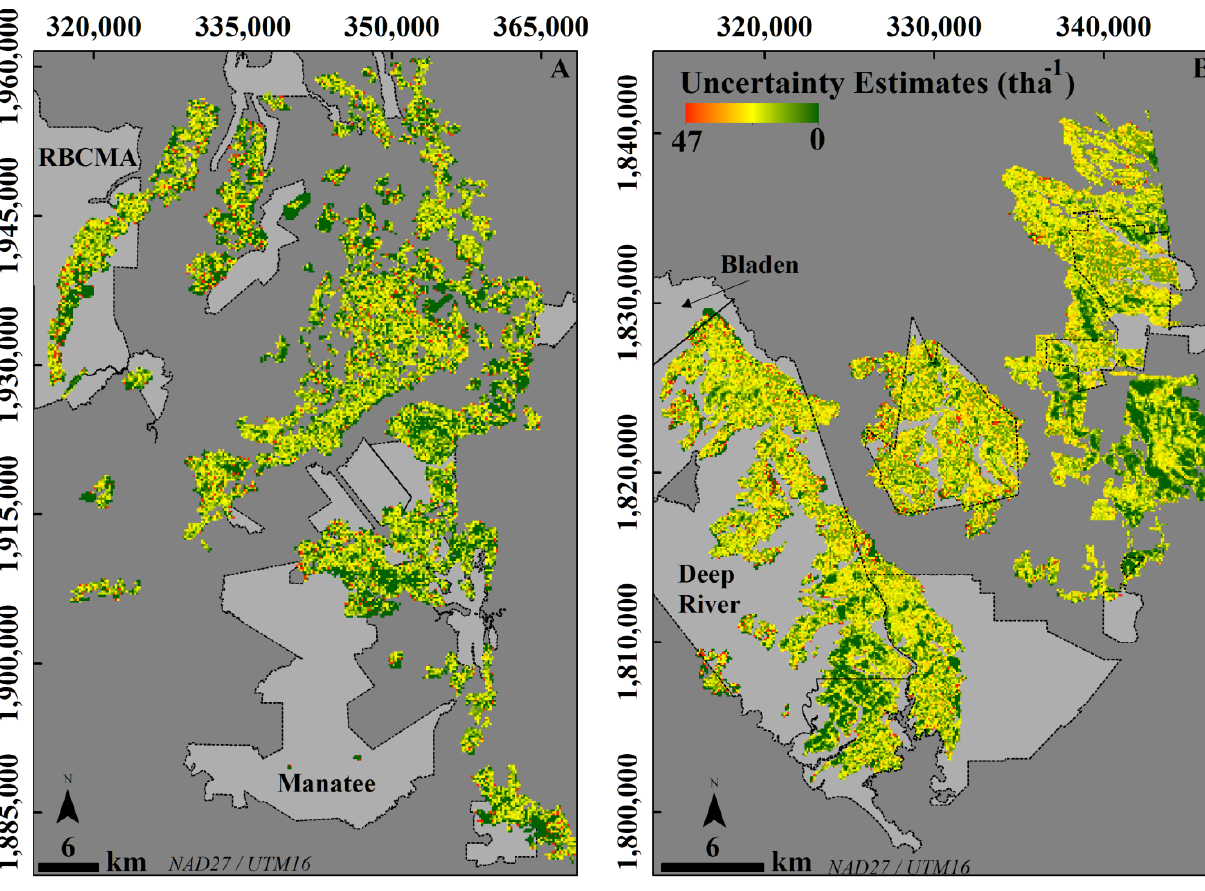
Figure 7. Uncertainty estimates for MBE 100 derived by ALOS PALSAR for ( A ) north Belize (Scene I) and ( B ) south Belize (Scene II), overlaid on protected area boundaries (light grey polygons with dashed lines as boundaries) that contain